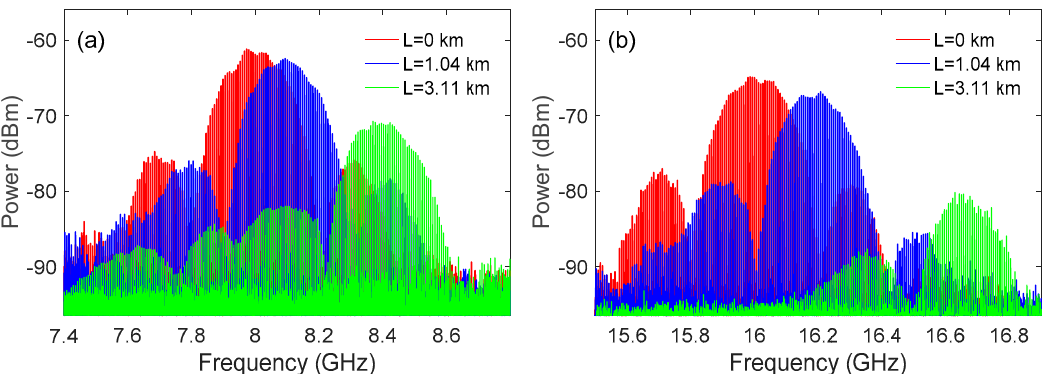
Figure 9. ( a ) The up-conversion spectrum for the 8 GHz input signal with different SMF lengths; ( b ) the up-conversion spectrum for the 16 GHz input signal with different SMF lengths.